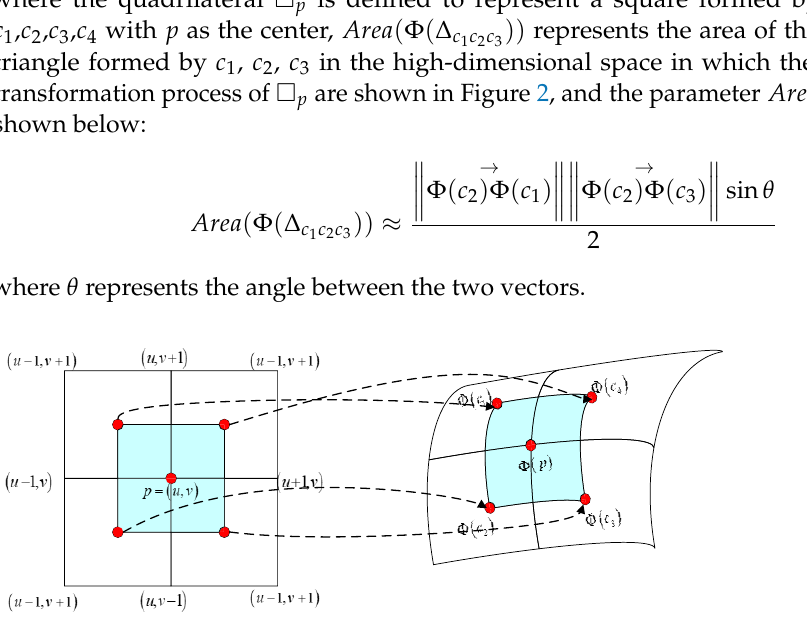
. Figure 2. The structure and transformation process of (cid:3) p p